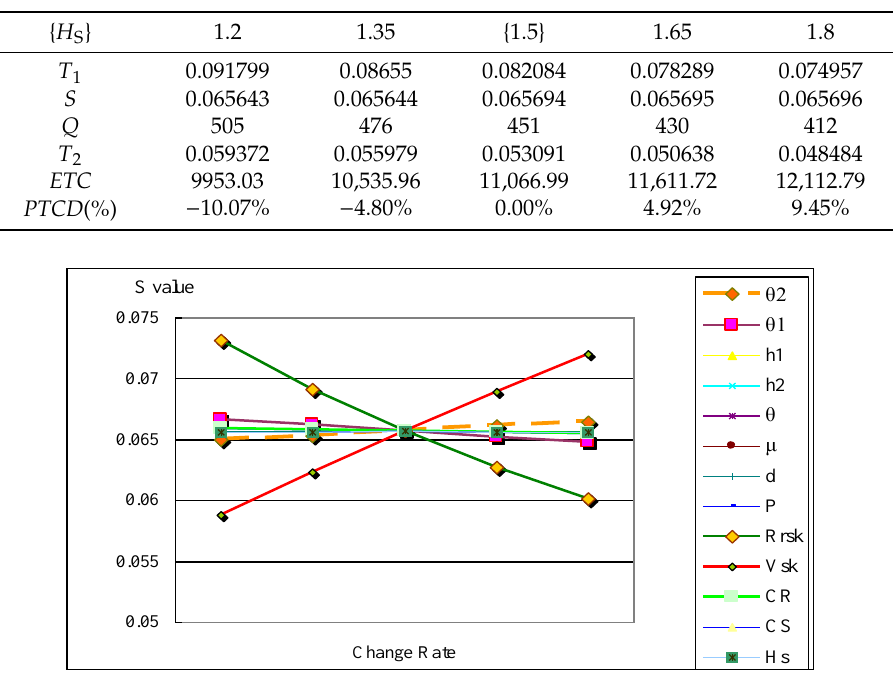
Figure 3. Sensitivity analysis for s when input parameters change.